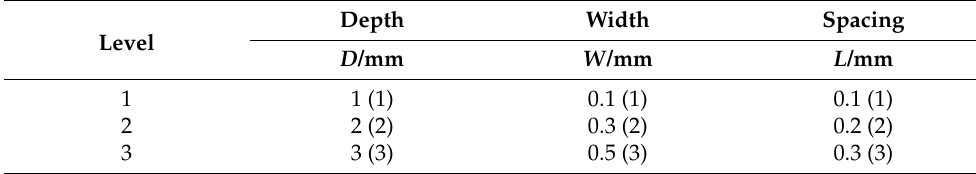
Table 1. Factors and levels table of piston ring groove texture.